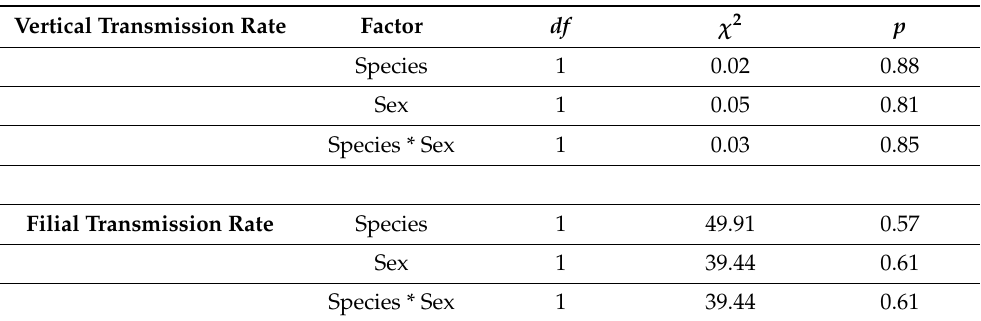
Table 2. Contingency table analysis of saliva expectorants of adult female progeny and whole-body assays of adult male progeny from infected parental Ae. aegypti and Ae. albopictus mosquitoes offered a Zika virus infected blood meal of 7 log 10 PFU/mL. The species by sex interaction is represented by Species * Sex.